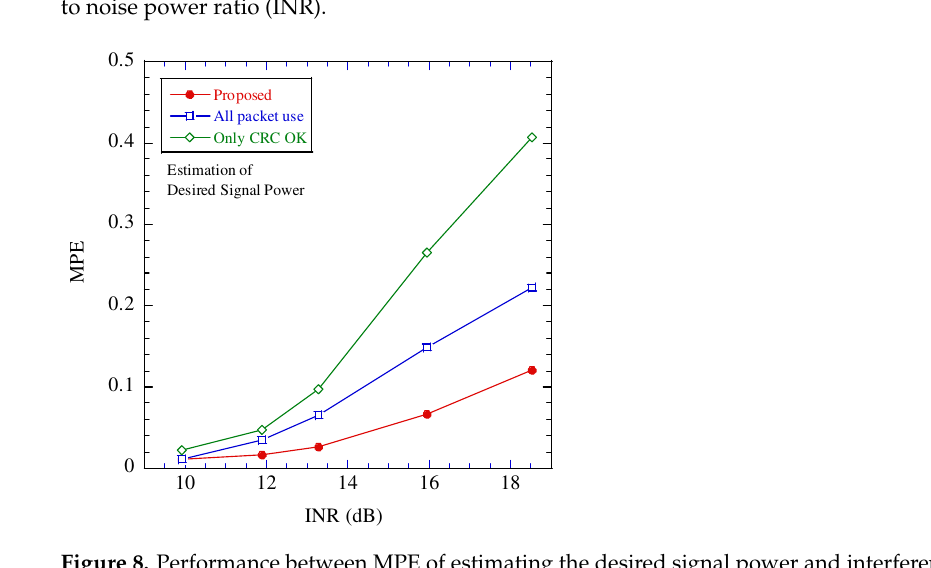
Figure 8. Performance between MPE of estimating the desired signal power and interference to noise power ratio